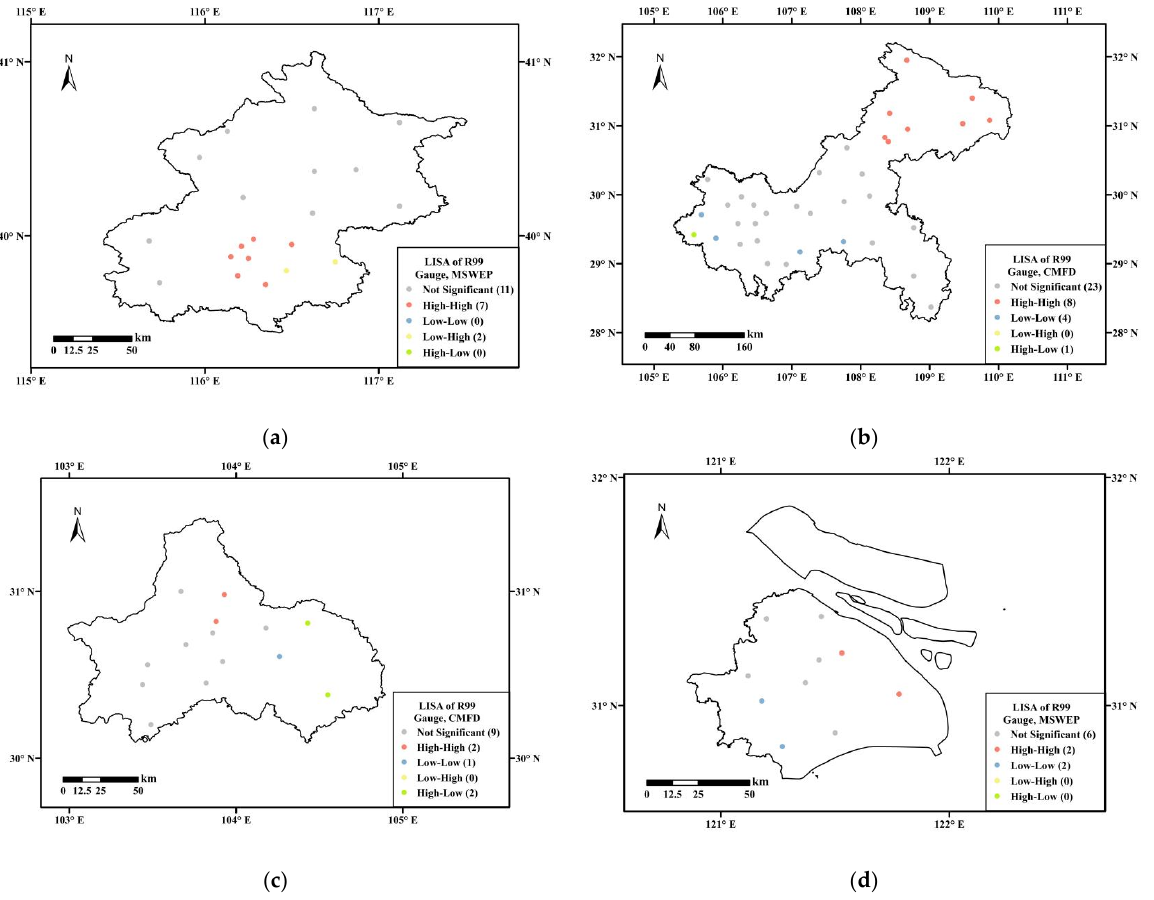
Figure 11. The LISA cluster maps of R99 between the gauge observations and SPPs with the highest BMI in four cities: ( a ) Beijing, ( b ) Chongqing, ( c ) Chengdu, and ( d ) Shanghai.